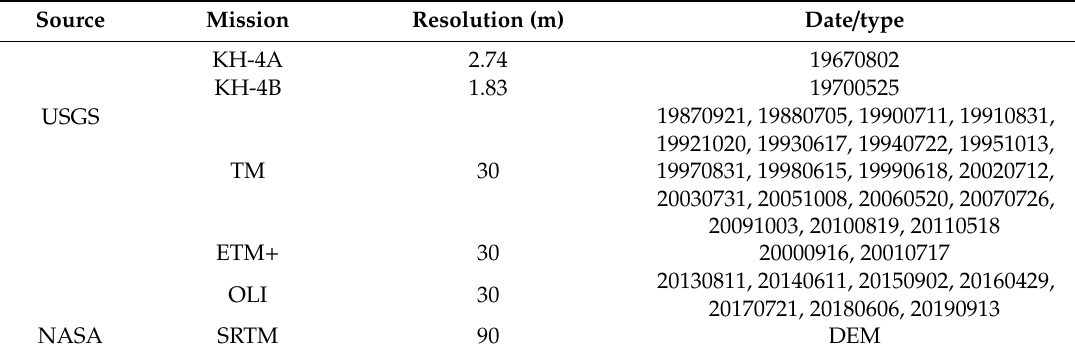
Table 1. Remote sensing data used in this